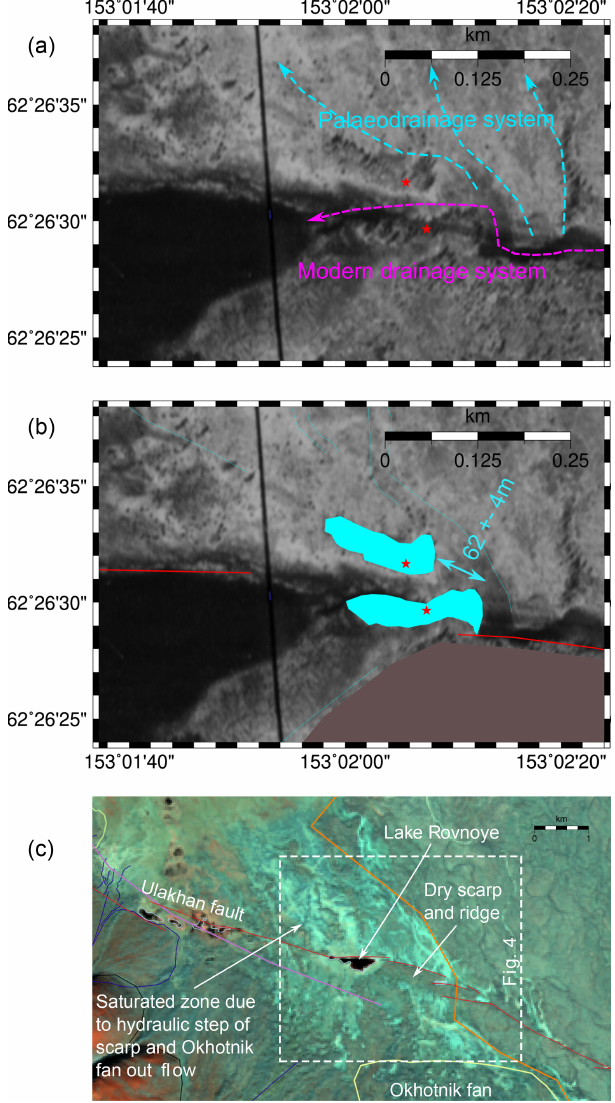
northwest-oriented palaeodrainage and sample localities ul1 and ul2, interpreted to be offset as part of abandoned channel system. (b) Aerial photo with interpretation, showing offset palaeo-channel feature. (c) Landsat (567 band) detail, showing hydrology of scarp and ridge with a dry ridge (dark coloured area) bounded north and south by saturated zone (light coloured area). For explanation of hydrology, see